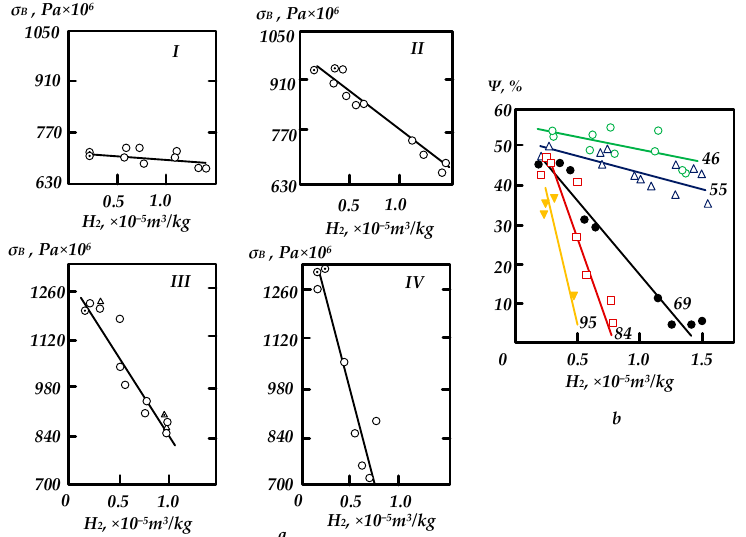
Figure 6. Dependence of the conditional ultimate strength ( a ) and relative contraction ( b ) of steel of different initial strength on the hydrogen content in it: I—460 × 10 6 Pa; II—690 × 10 6 Pa; III—840 × 10 6 Pa; IV—950 × 10 6 Pa [26].